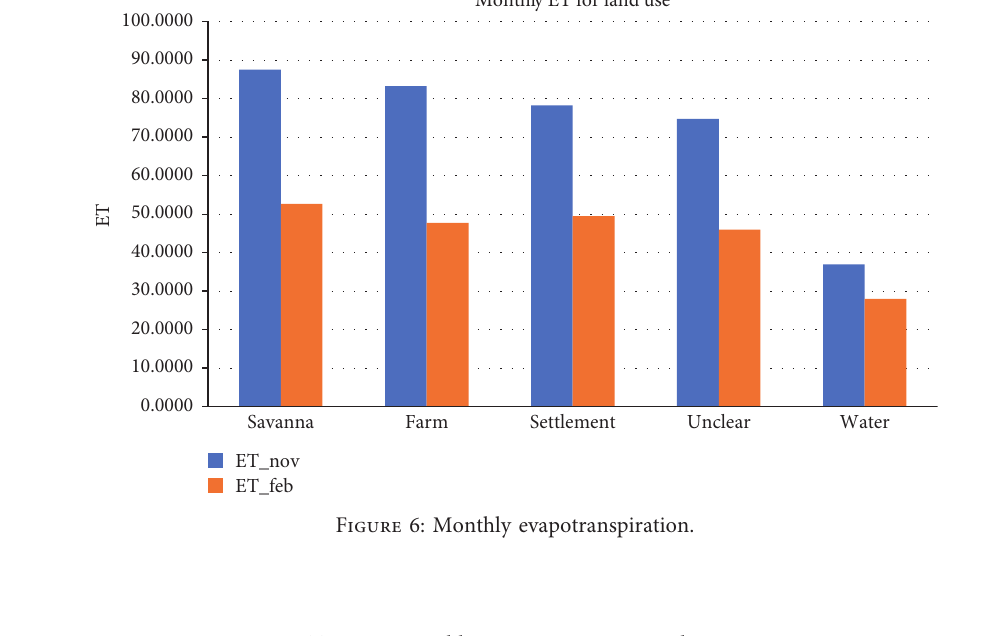
Table 3: Monthly evapotranspiration